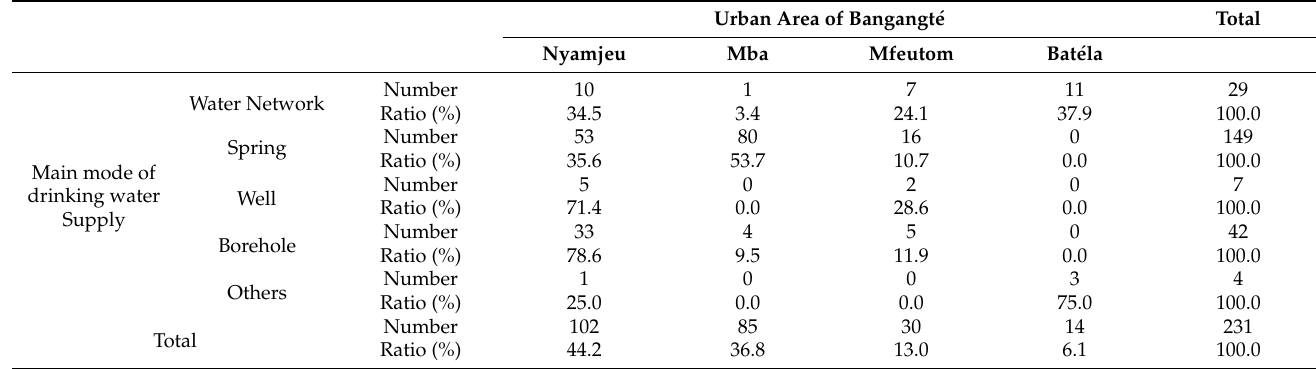
Table 2. Main mode of drinking water supply in the city of Bangangt é based on ref. [5].